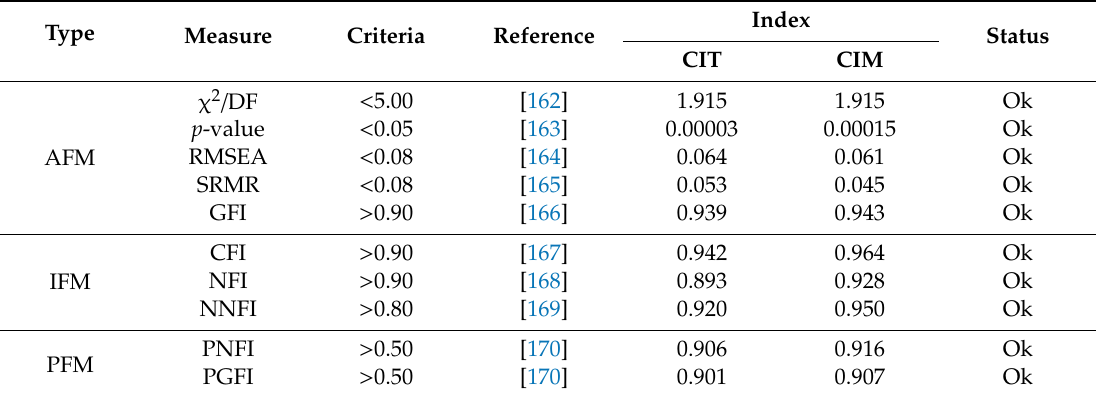
Table 20. Goodness of fit model results.